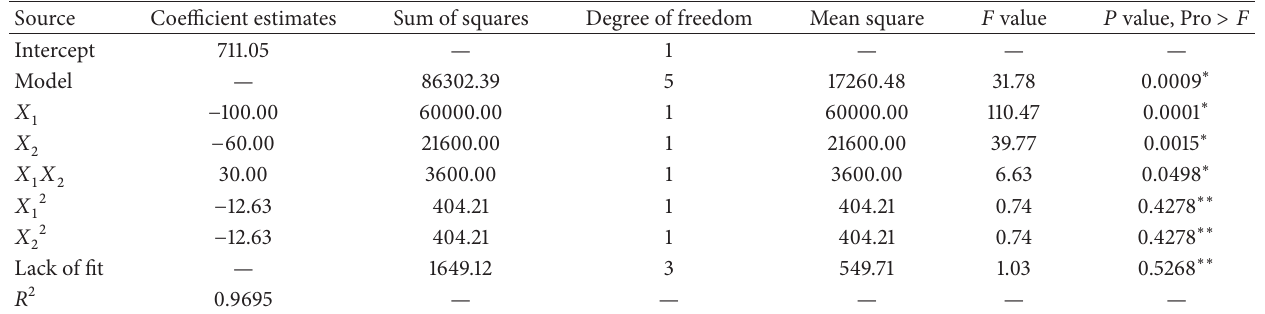
Table 3: Analysis of variance (ANOVA) for the effects of microwave power and time on drying time.